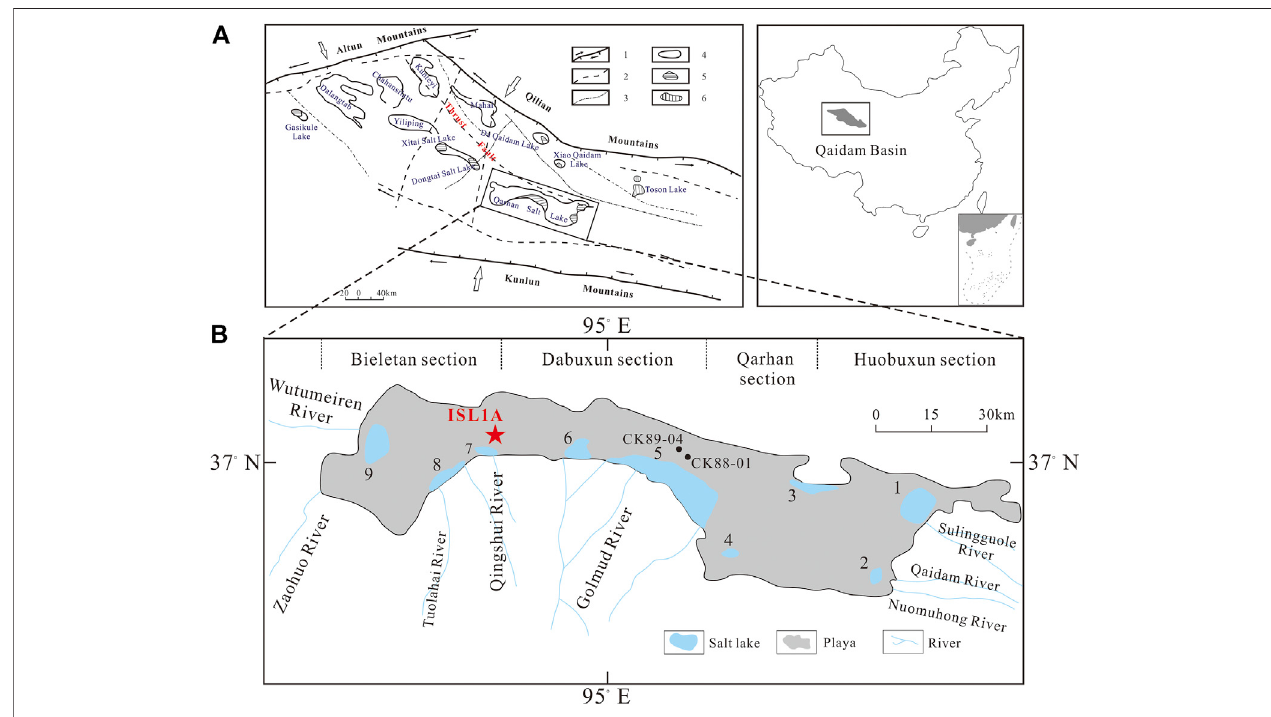
FIGURE1| TectonicoutlineandsaltlakesintheQB(Lietal.,2020). (A) MapshowingthetectonicdivisionsoftheQBandthelocationofQarhanSaltLake(QSL).1: grade Ⅰ structural line controlling the boundary of the Qaidam ancient block; 2: grade Ⅱ structural line controlling the Qaidam Basin; 3: grade Ⅲ structural line controlling the salt lake belt; 4: salt playa; 5: brine lake; 6: brackish water lake. (B) Location of drillholes ISL1A, CK89-04, and CK88-01 in QSL.